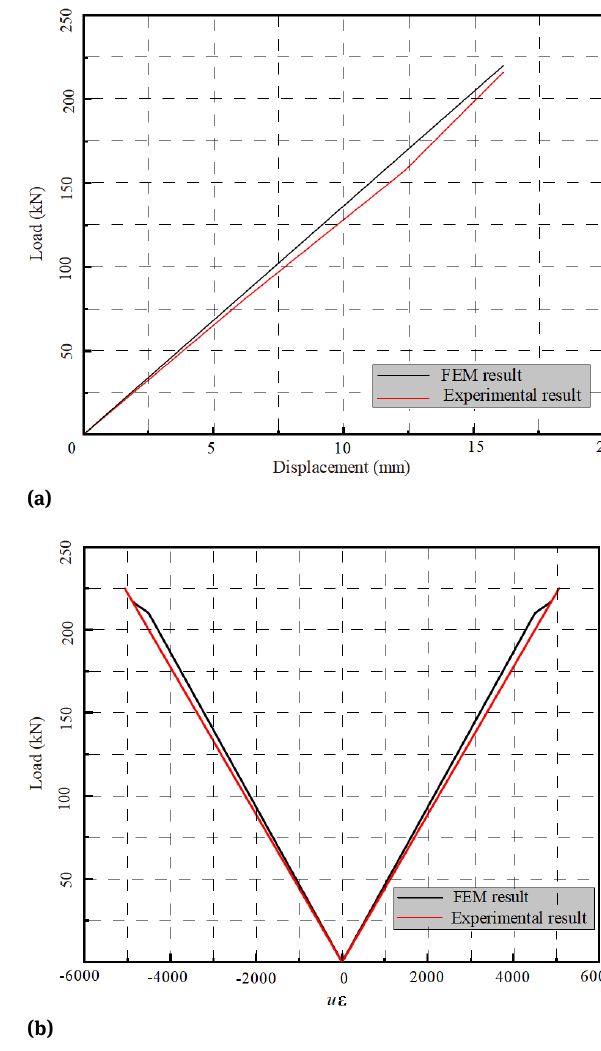
Figure 10: The model of FEA. (a) meshing and loading setup, (b) the stress of facesheets. Figure 11: Comparison between test result and FEA result. (a) load- displacement curve, (b) load-strain